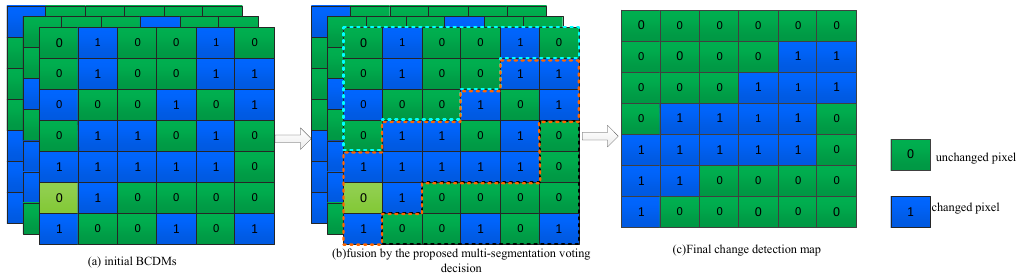
Figure 2. Example of the proposed multi-scale segmentation voting decision.